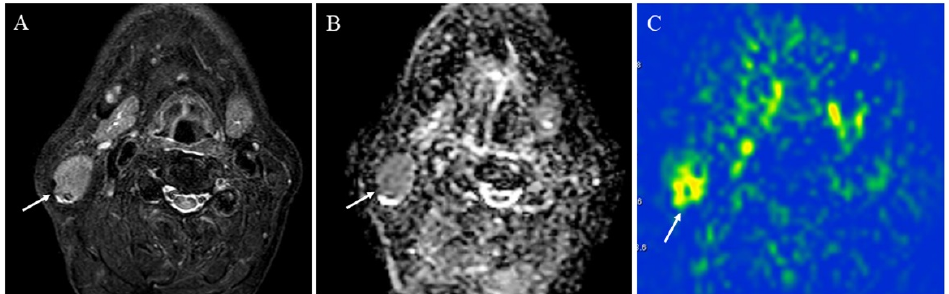
Figure 11. A 75-year-old male with Warthin’s tumor of the right parotid gland: ( A ) STIR shows a mass with high signal intensity (arrow); ( B ) ADC map shows restricted diffusion (arrow) (ADC 10th percentile, 0.70 × 10 − 3 mm 2 /s and ADC mean of 0.85 × 10 − 3 mm 2 /s); ( C ) pCASL image shows high TBF (arrow) (TBF 50th percentile, 150.53 mL/100 g/min).